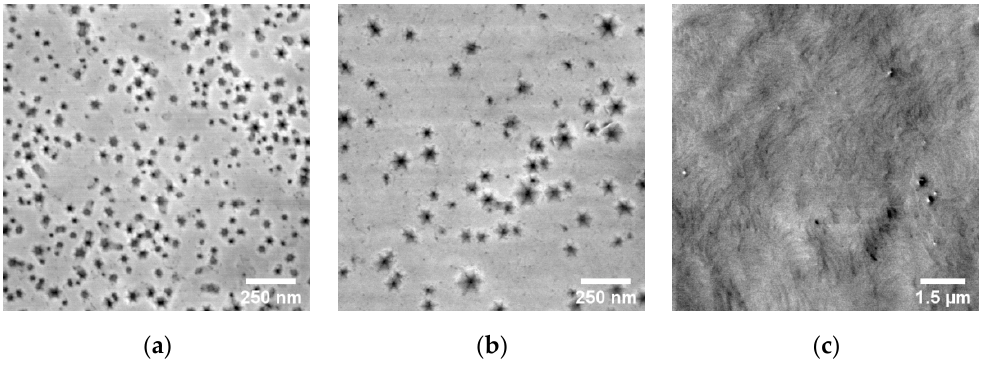
Figure 3. Representative scanning electron microscope (SEM) images of the as-grown surfaces of structure A ( a ), structure B ( b ), and structure C ( c ).